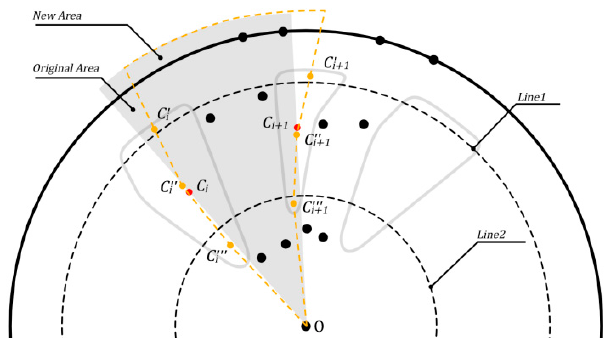
Figure 6. Optimization of feature point detection area. Line 1 and Line 2 divide the window on each side of the spokes into three subareas, and the geometric center of each subarea together with the center O forms the construction point of the optimized detection area. Compared to the original area, the new area be tt er fi ts the shape trend of the spokes.